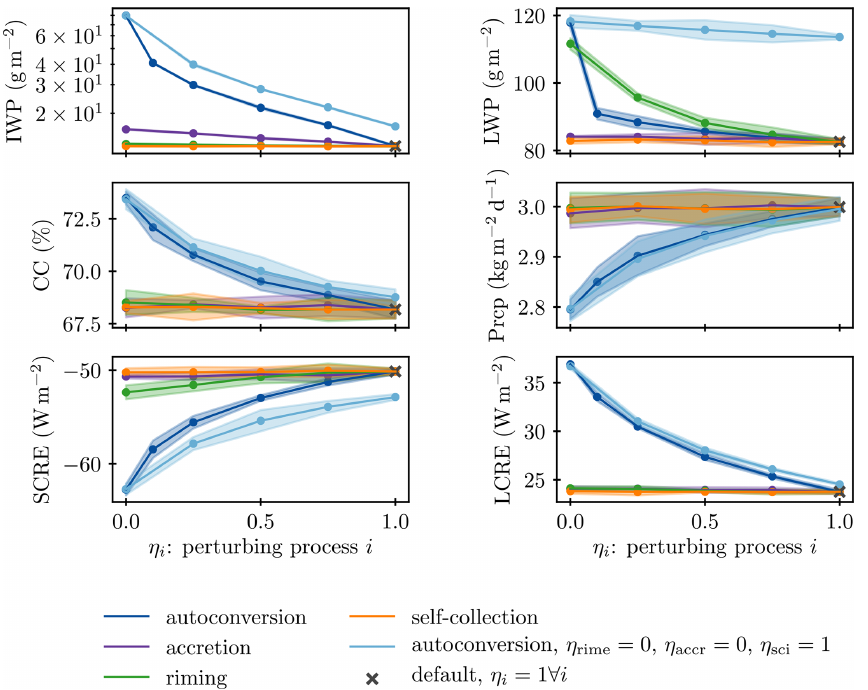
Figure 5. Model response to perturbations of four CMP processes: autoconversion, accretion, riming, and self-collection (as illustrated in Fig. 1) in terms of global annual mean IWP, liquid water path (LWP), cloud cover (CC), precipitation (Prcp), and shortwave and longwave cloud radiative effect (SCRE, LCRE). An additional experiment was conducted to highlight interactive effects between the perturbation of autoconversion and the suppression of riming and accretion (light blue). The points and line indicate the mean, and the shading indicates 2 times the standard deviation of annual mean values of a 5-year simulation. Classical sensitivity studies would only show η i = 0 and η i = 1. Note that we added an extra simulation at η autc = 0 . 1 to better illustrate the threshold behavior discussed in the text and that for the IWP the shading is hidden behind the